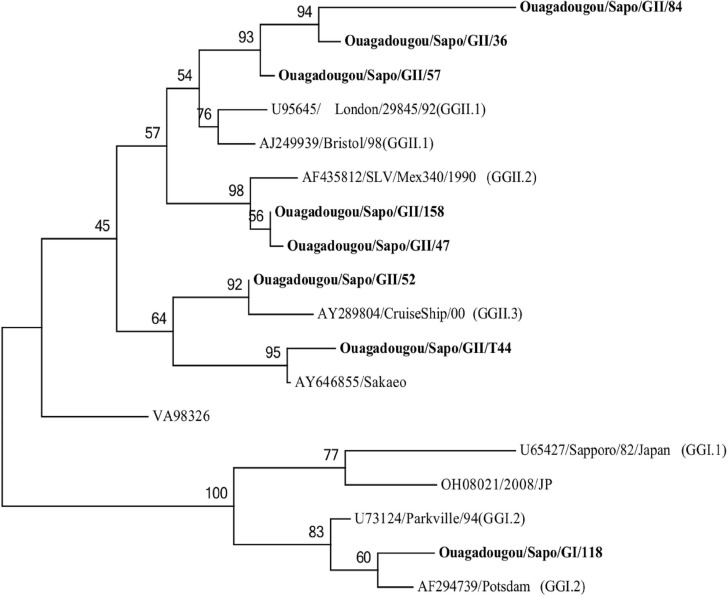
Phylogenetic analysis based on the partial nucleotide sequences (277 bp) of an area located in the open-reading frame (ORF2) of sapovirus strains detected in Ouagadougou, Burkina Faso, between November 2011 and September 2012.The tree was constructed using Maximum Likelihood method. Reference strains of sapovirus were selected from the GenBank database.